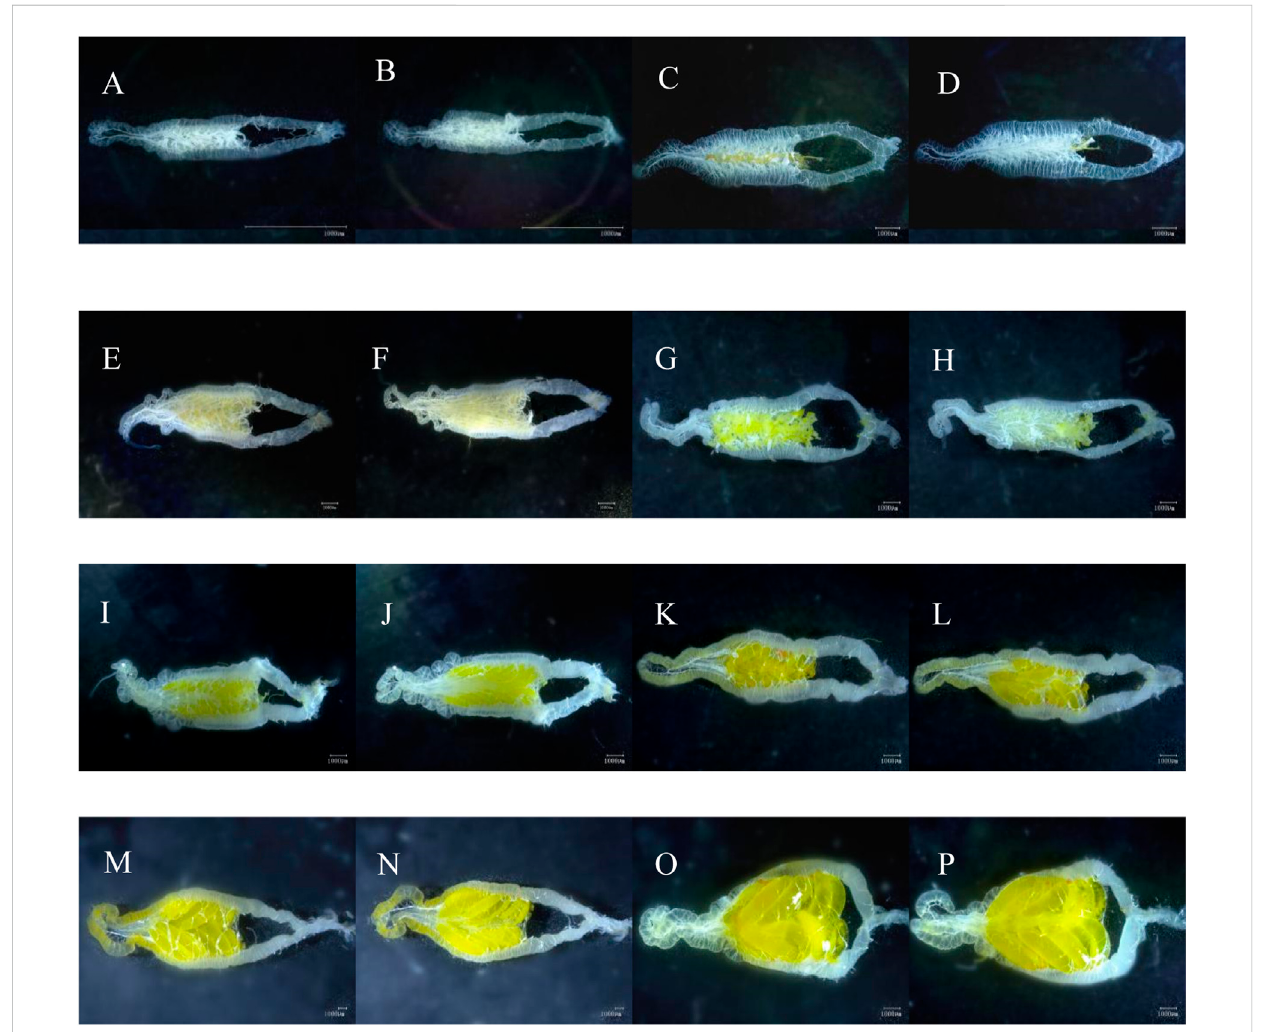
FIGURE 1 Visual view of C. kiangsu ovarian morphology. (A) Ventral view at stage Ⅰ , (B) dorsal view at stage Ⅰ , (C) ventral view at early-stage Ⅱ , (D) dorsal view at early-stage Ⅱ , (E) ventral view at end-stage Ⅱ , (F) dorsal view at end-stage Ⅱ , (G) ventral view at early-stage Ⅲ , (H) dorsal view at early-stage Ⅲ , (I) ventral viewatend-stage Ⅲ , (J) dorsalviewatend-stage Ⅲ , (K) ventralviewatearly-stage Ⅳ , (L) dorsalviewatearly-stage Ⅳ , (M) ventralviewatend-stage Ⅳ , (N) dorsal view at end-stage Ⅳ , (O) ventral view at stage Ⅴ , and (P) dorsal view at stage Ⅴ (scale bars = 1,000 μ